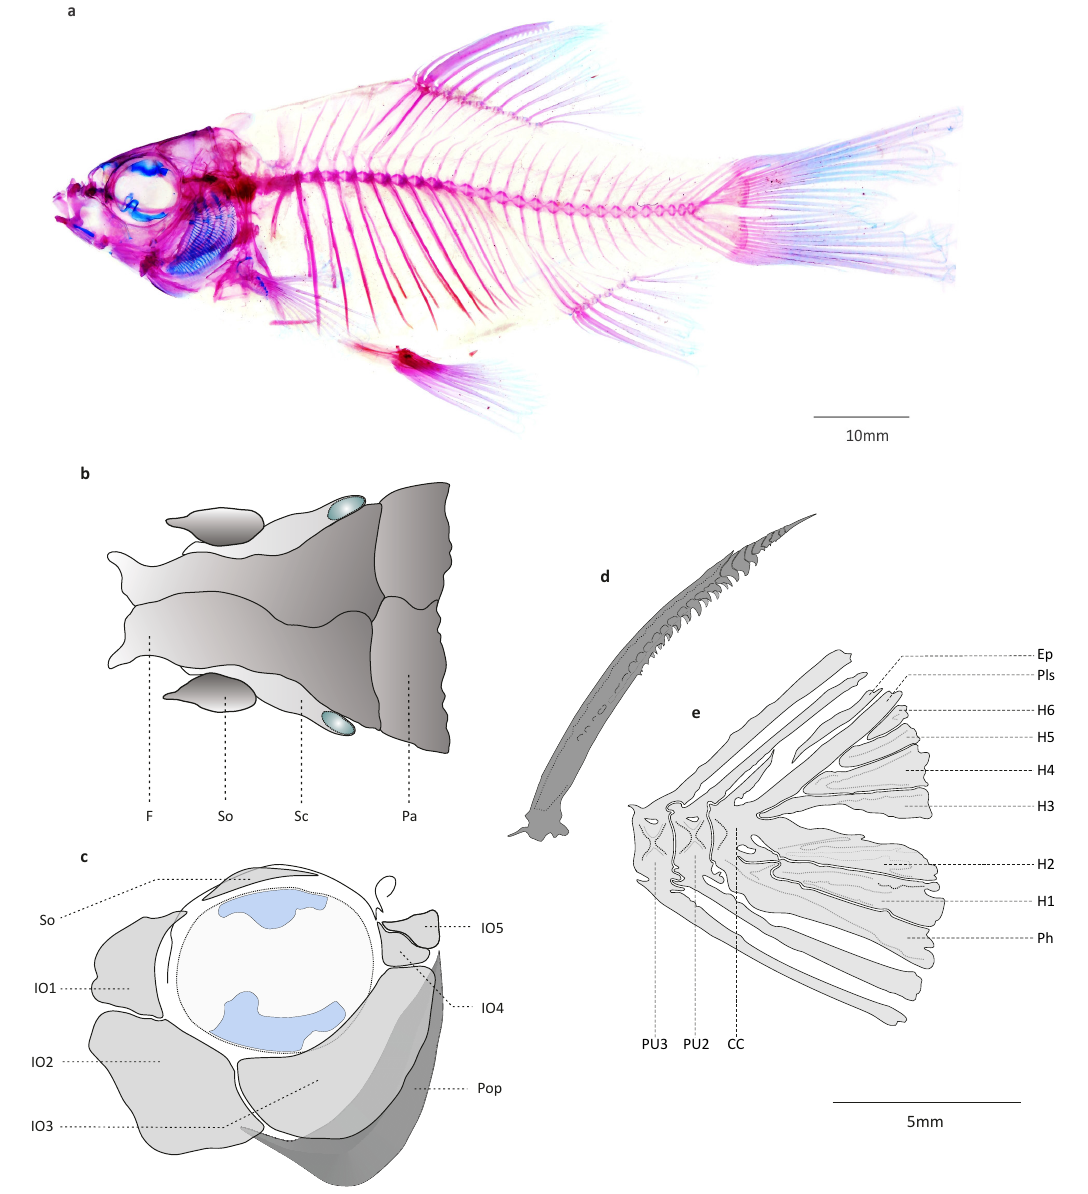
Image 5. Pethia setnai topotypic material from Sanguem, Goa (BNHS FWF 70, 32.1mm SL: (a) cleared and stained specimen; (b) dorsal view of orbital region of cranium (F, frontal; Pa, parietal;; Sc, supraorbital sensory canal); (c) circumorbital series (So, supraorbital; IO1-5,